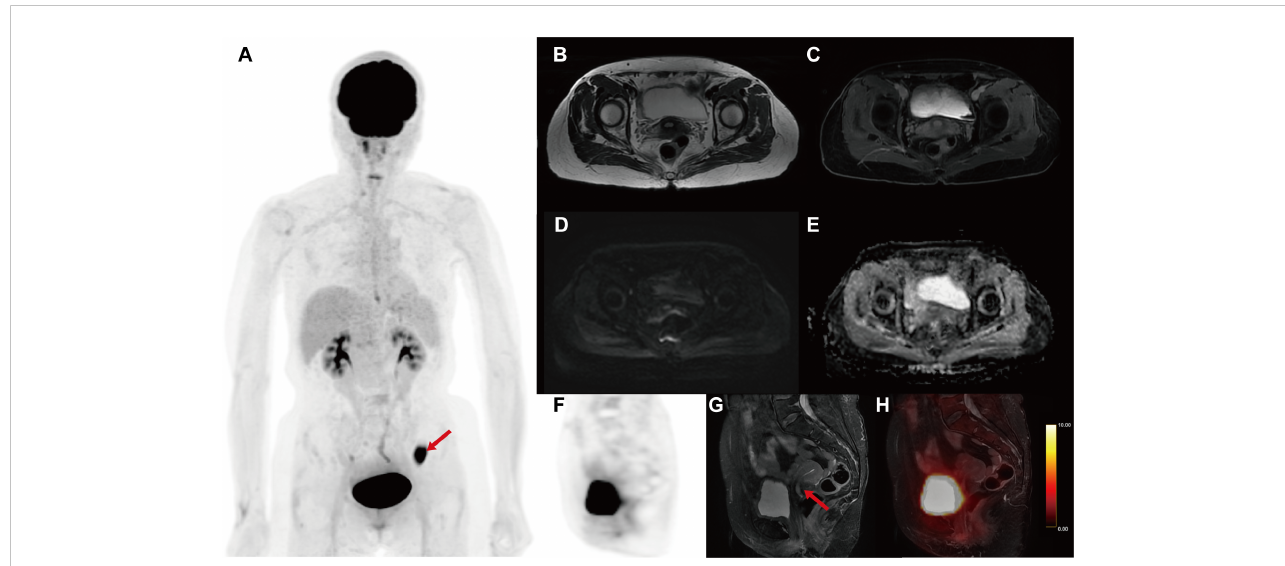
FIGURE 1 The multimodal 18F-FDG PET/MR images for evaluating the uterine. (A) MIP image of whole-body PET. (B) Axial T2WI. (C) Axial T1WI+C. (D) Axial DWI. (E) Axial apparent diffusion image (ADC) map. (F) Sagittal PET image. (G) Sagittal fs T2WI. (H) Sagittal PET/T2WI fusion image. On the pelvic sagittal MRI, there was a polypoid mass in the lower segment of the uterine (red arrow). The polypoid lesion showed a slightly high intensity signal on T1WI and fs T2WI, but no restricted diffusion signal in DWI and ADC. A mild enhancement of the lesion was observed on T1WI+C. The PET and PET/MR fusion images showed slight hypermetabolism in the lesion (SUV max = 5.7g/ml). Unexpectedly, the MIP image of whole-body PET revealed an abnormal hypermetabolism in the left lower abdomen (red arrow, SUV max = 17.68